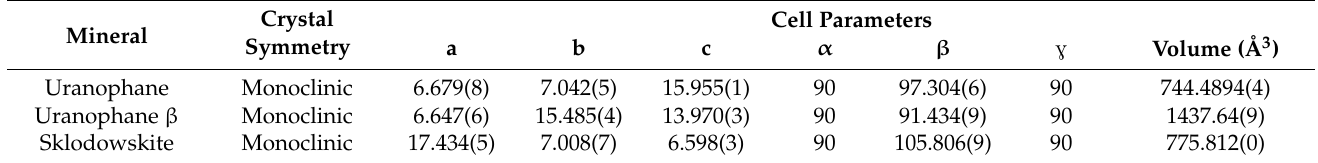
Figure 5. XRD patterns of uranyl silicates from Podg ó rze mine. Urp- β , uranophane- β ; Urp- α , uranophane; Sds, sklodowskite. Table 3. Unit cells parameters of uranyl silicates from Podg ó rze